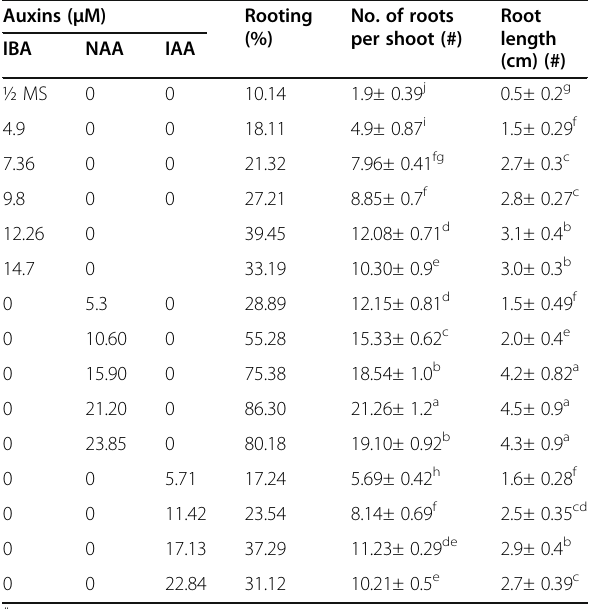
Table 2 Effect of auxins on root induction in in vitro regenerated shoots of S. mollis in half-strength MS medium after 6 weeks of